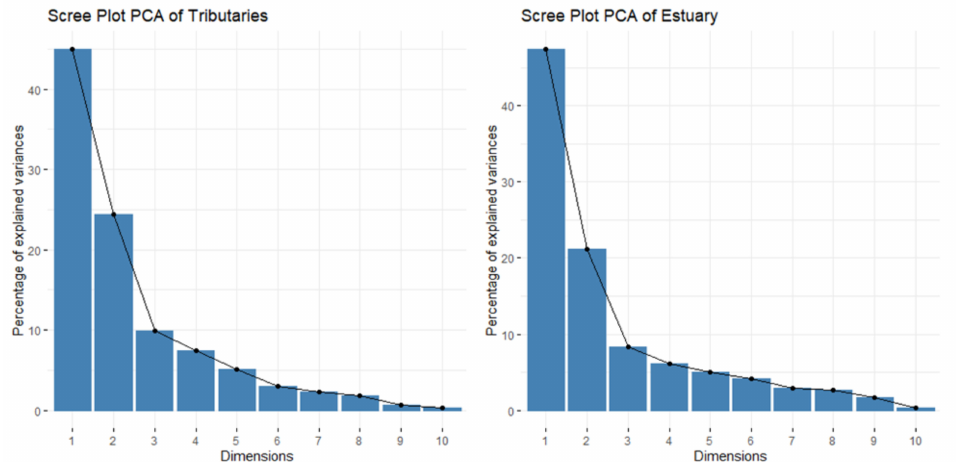
Figure 4. The scree plots of the PCA of samples from the tributaries ( left ) and those from the estuary ( right ) indicate the percent variance explained by each dimension.